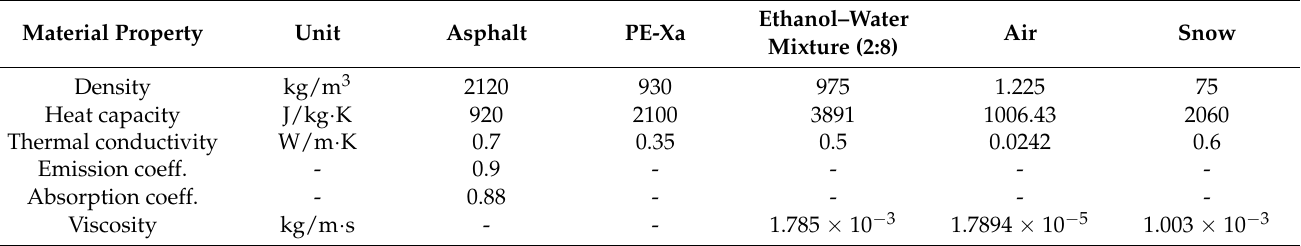
Table 2. Material properties implemented in ANSYS Fluent for CFD simulations